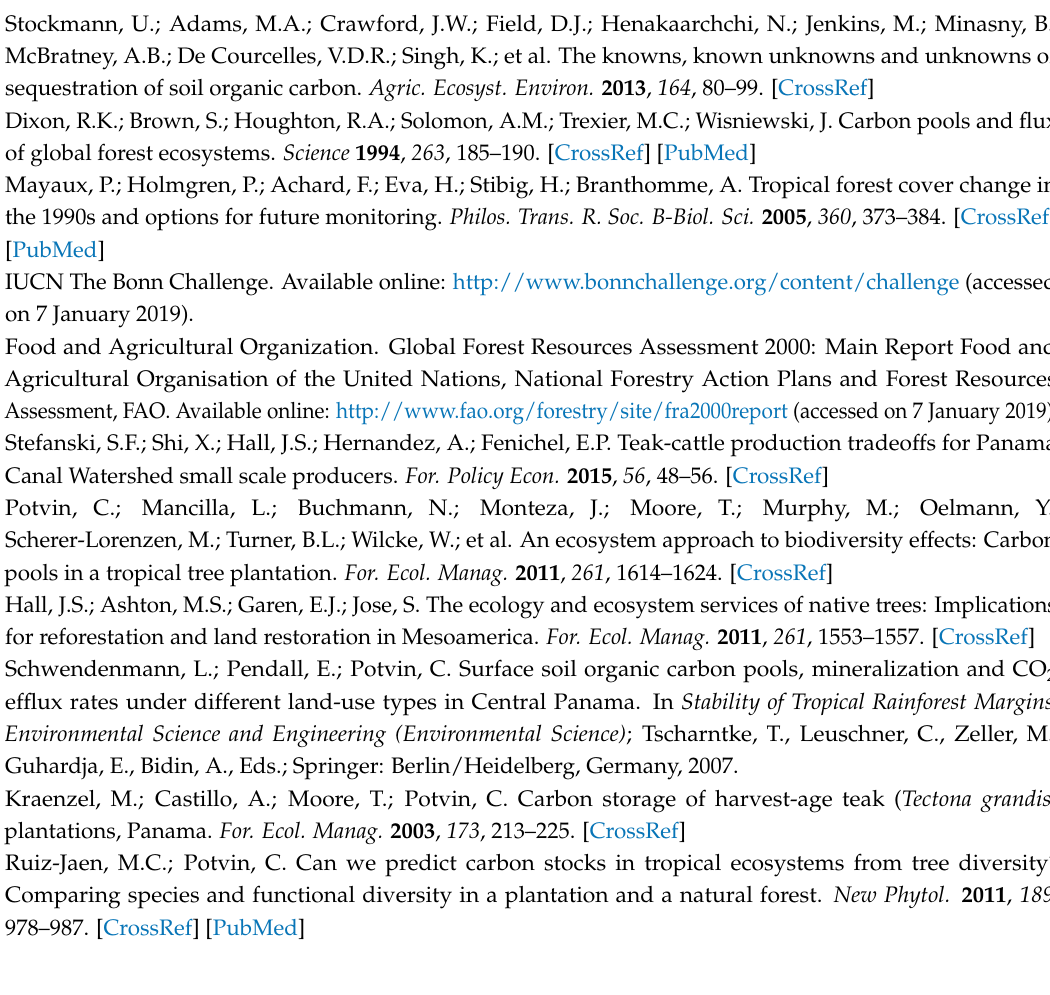
Figure S1: Soil temperature in monoculture plantations of Tectona grandis , Dalbergia retusa and Terminalia amazonia during a litter decomposition experiment of the Agua Salud project in Panama, Figure S2: Soil moisture in monoculture plantations of Tectona grandis , Dalbergia retusa and Terminalia amazonia during a litter decomposition experiment of the Agua Salud project in